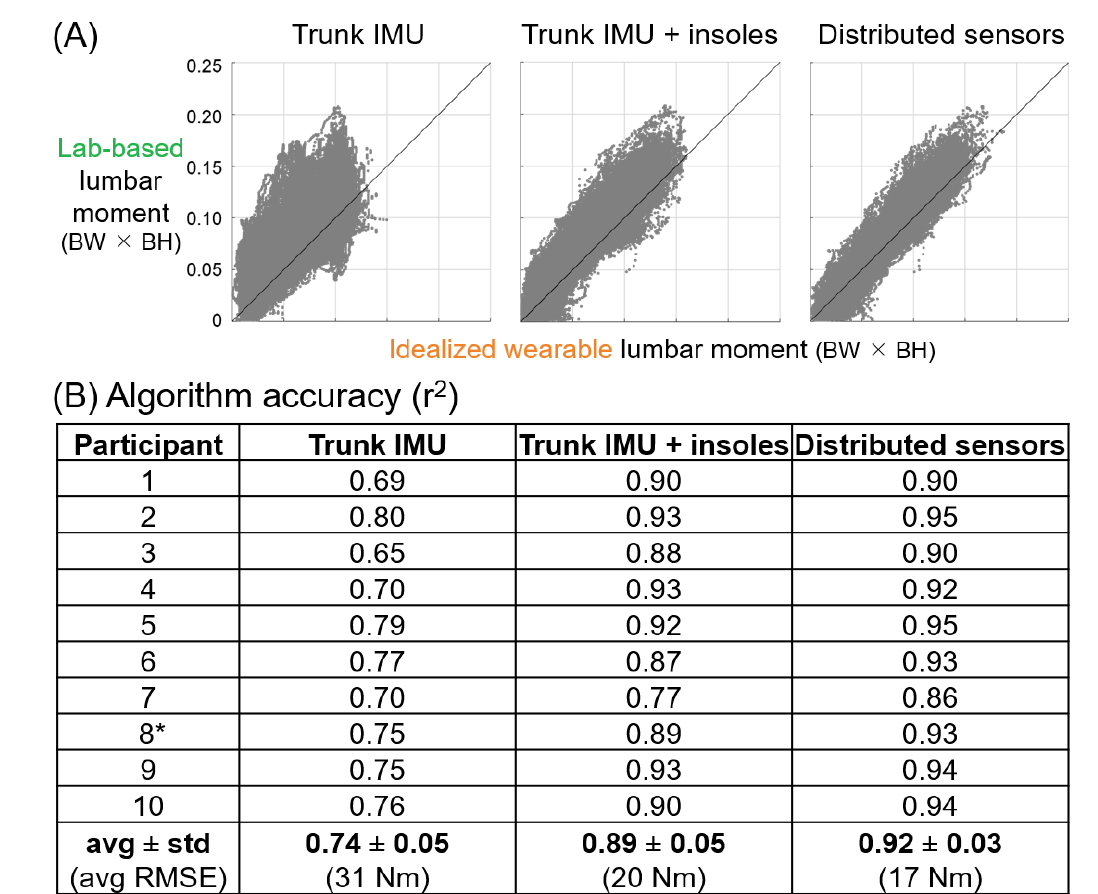
Figure 4. Algorithm accuracies for three idealized wearable sensor algorithms. ( A ) Lab-based (gold-standard) lumbar extension moment vs. idealized wearable algorithm estimates of lumbar moment for all time samples for an example participant (participant 8*). Positive moments correspond to lumbar extension moments. A line with a slope of one is added to visualize a perfect correspondence between lab-based and wearable estimates. BW × BH = body weight × body height. ( B ) Coefficient of determination (r 2 ) for each participant. Average results (avg, bottom) are equivalent to accuracies in Figure 2. The trunk IMU algorithm was less accurate than the trunk IMU and pressure insoles algorithm, and than the distributed sensors algorithm ( p < 0.001 and p < 0.001, respectively, based on Wilcoxon signed-rank test of the k-fold cross validation accuracy results). Comparing accuracies from the trunk IMU and pressure insoles algorithm vs. the distributed sensors algorithm yielded p = 0.054. Average RMSE was converted into units of Nm (using mean participant height and weight) and included for reference.